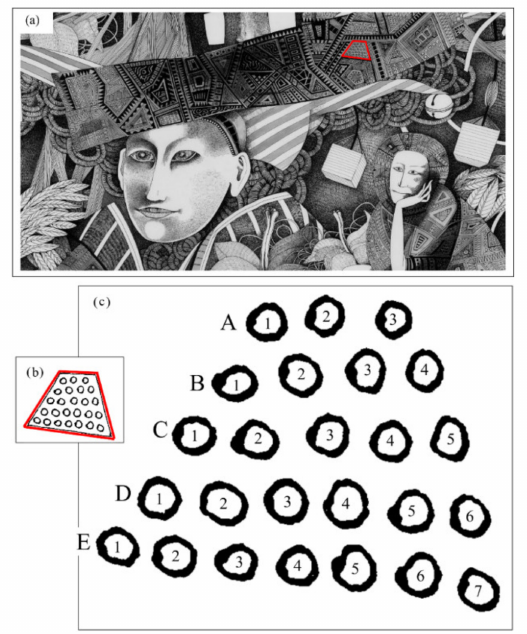
Figure 15. Graphic drawing as an object for morphological assessment. ( a ) Fragment of graphic drawings. Credit: Reproduced by permission of artist O. Nenazhivina [25]; www.nenazhivina.com (accessed on 25 June 2021). ( b ) Local area for the morphological description. ( c ) Coordinate system of the local